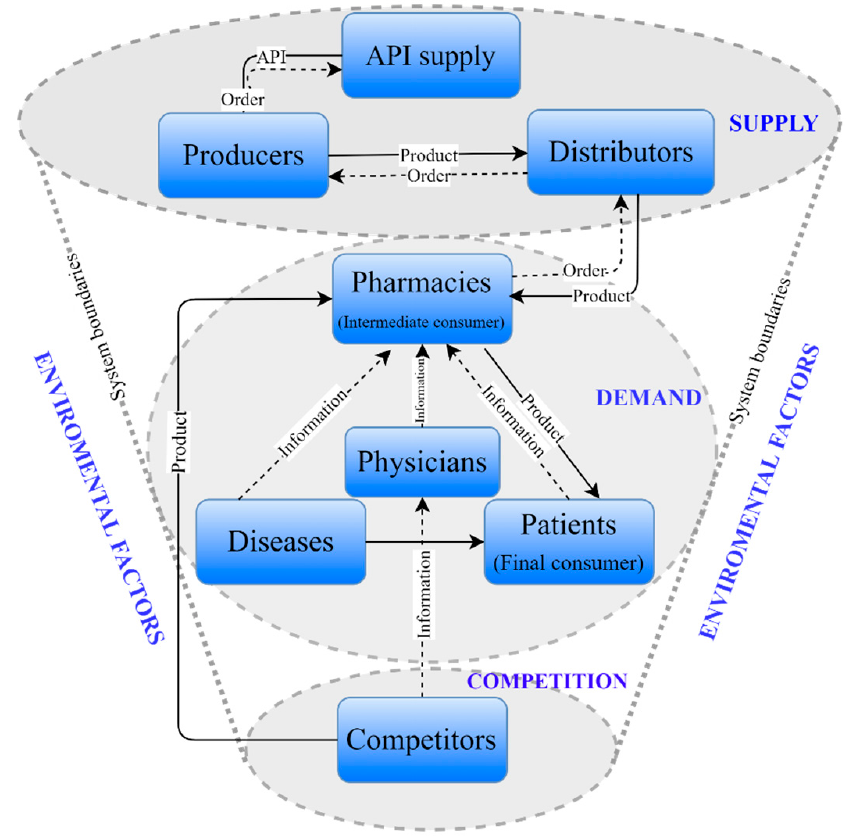
Figure 1. Conceptual model of the product life cycle in pharmaceutical products .